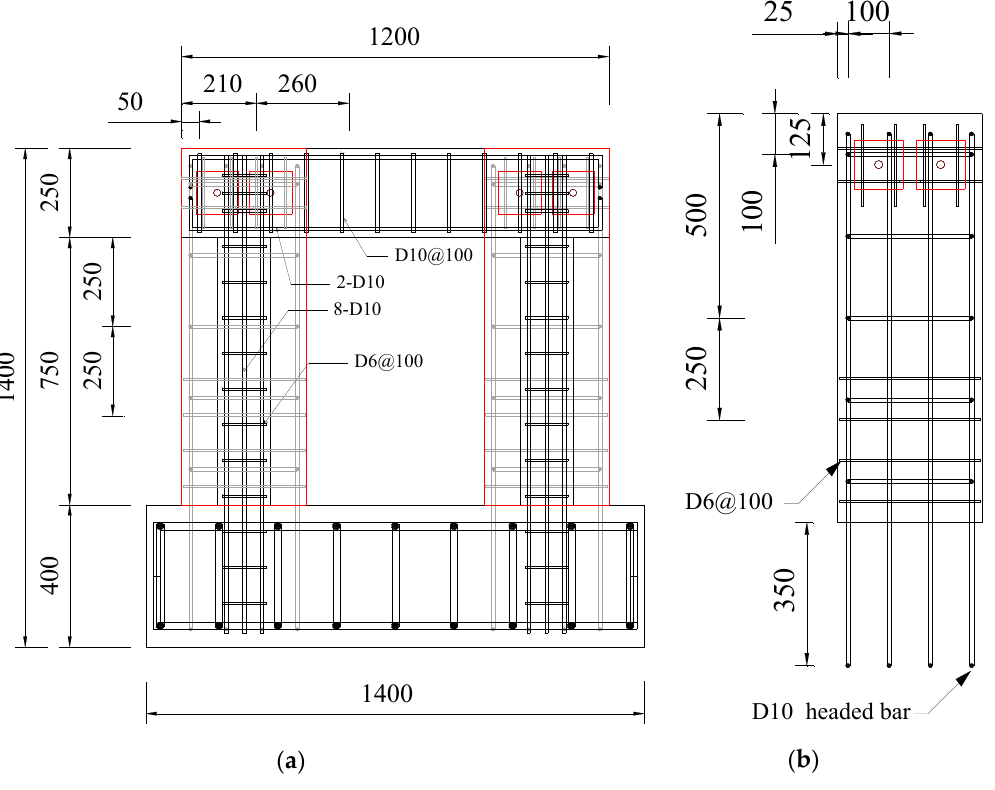
Figure 4. Details of Specimen FPB (unit: mm): ( a ) reinforcement details of frame; ( b ) reinforcement details of wall.